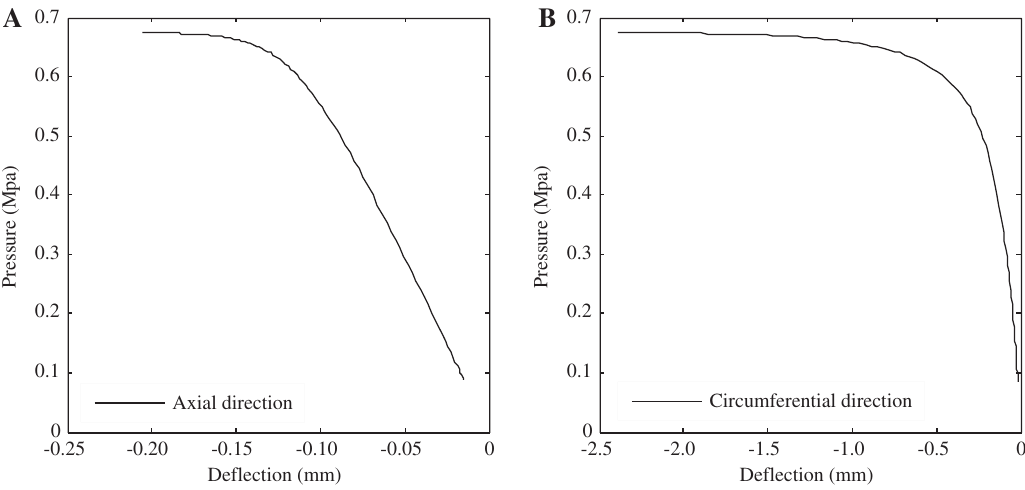
Figure 7: Typical pressure vs. deflection curves at point Q (CTM3). (A) Axial direction. (B) Circumferential direction.